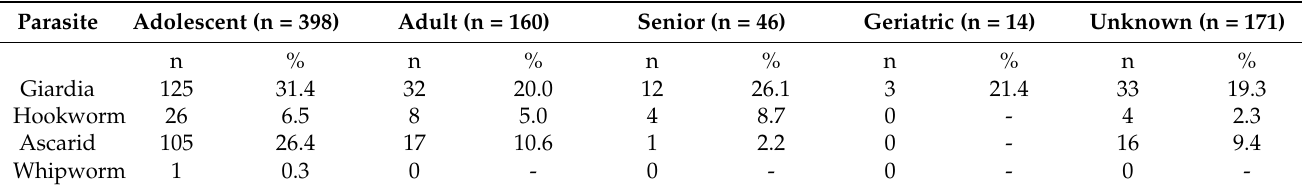
Table 2. Prevalence of parasites detected in the different life stages of dogs.